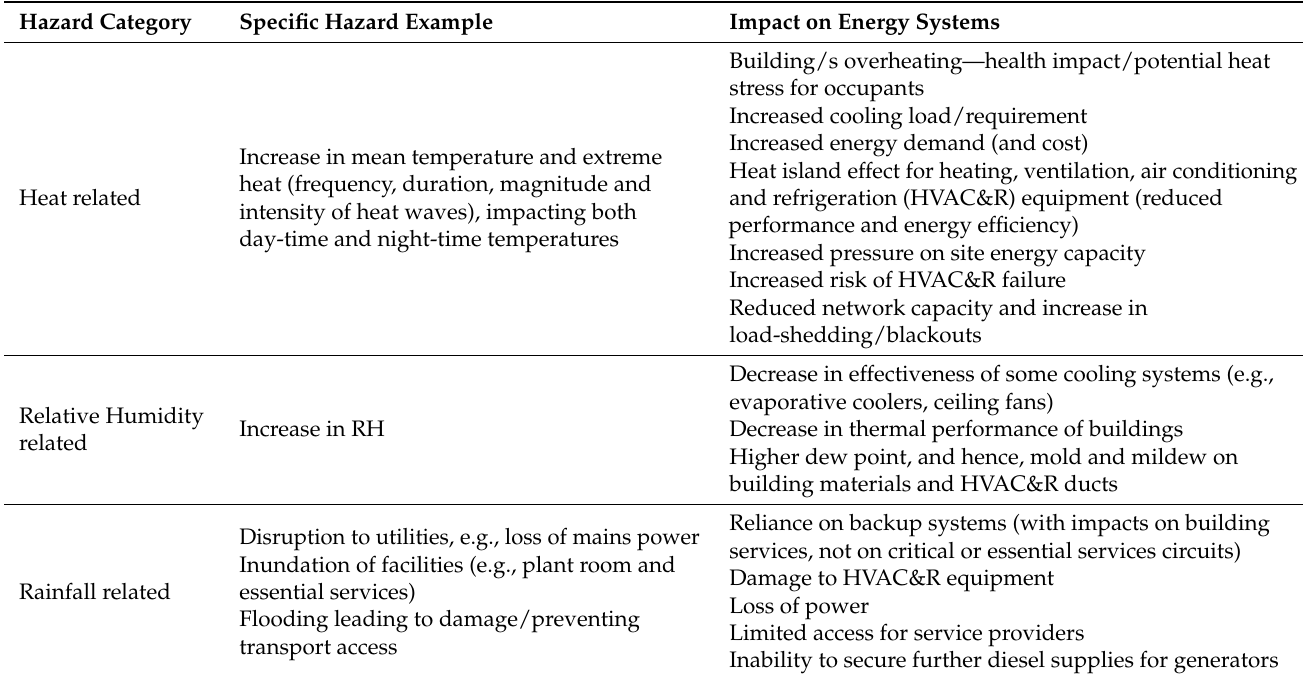
Table 2. Climate-related hazards and energy-associated impacts for healthcare facilities (Derived from Ref. [33] Palutikof, Jean, Sarah Boulter, Peter Schneider, and Fahim Tonmoy. “Climate